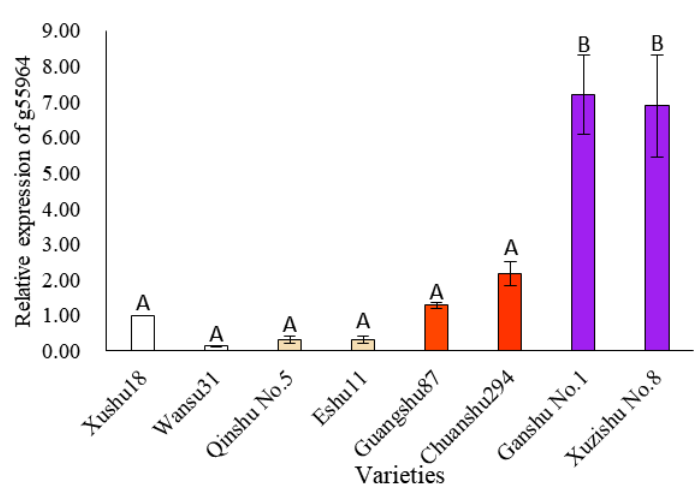
Figure 9. g55964 expression comparisons between different colors of flesh by RT-qPCR. The SRFC in ‘Xushu18 ′ and ‘Wansu31 ′ are white, the SRFC in ‘Qinshu No.5 ′ and ‘Eshu11 ′ are light-yellow, the